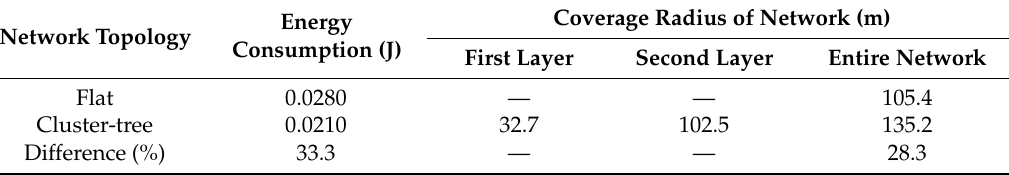
Table 6. Comparison of clustering and